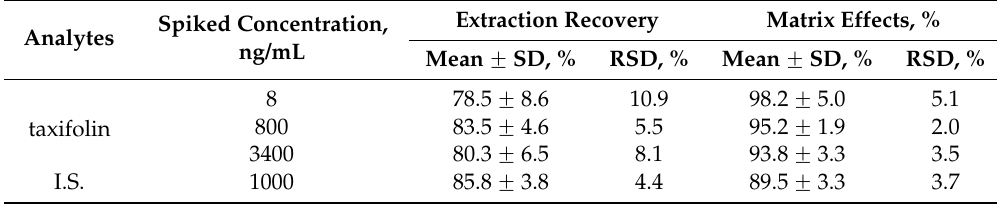
Table 1. Extraction recovery and matrix effect of taxifolin and butylparaben (I.S.).